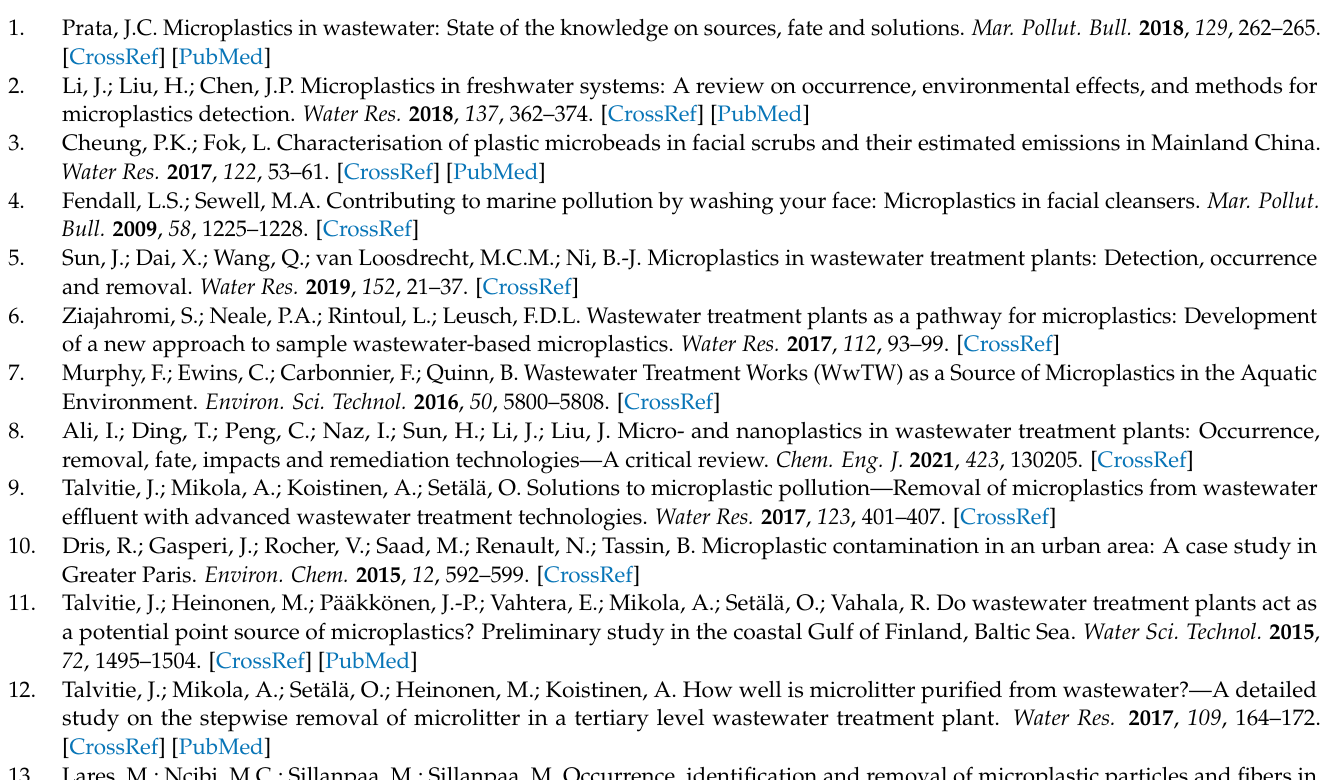
microplastics, with an average pore size of 0.1 µ m for the Synder, SteriLUX ® , and Anodisc membranes. Figure S4. (a) Turbidity and (b) TS retention of 0.1 µ m and 1.0 µ m PS microplastics with an average pore size of 0.1 µ m for the Synder, SteriLUX®, and Anodisc membranes. Figure S5. Volume-weighted particle size distribution and cumulative size distribution curves of (a) PS microplastic and (b) PE microplastics with an average size of 1.0 µ m. The x-axis has a logarithmic scale. Figure S6. (a) Turbidity and (b) TS retention of 1.0 µ m polystyrene (PS) and polyethylene (PE) microplastics with an average pore size of 1.0 µ m for the Synder, SteriLUX ® , and Anodisc membranes. Figure S7. Normalized water flux decline of 0.1 µ m PS microplastics in identical and synthetic wastewater for (a) Synder, (b) SteriLUX ® , and (c) Anodisc membranes. Figure S8. Normalized water flux decline of 1.0 µ m PS microplastics in identical and synthetic wastewater for (a) Synder, (b) SteriLUX ® , and (c) Anodisc membranes. Figure S9. Normalized water flux decline of 1.0 µ m PE microplastics in identical and synthetic wastewater for (a) Synder, (b) SteriLUX ® , and (c) Anodisc